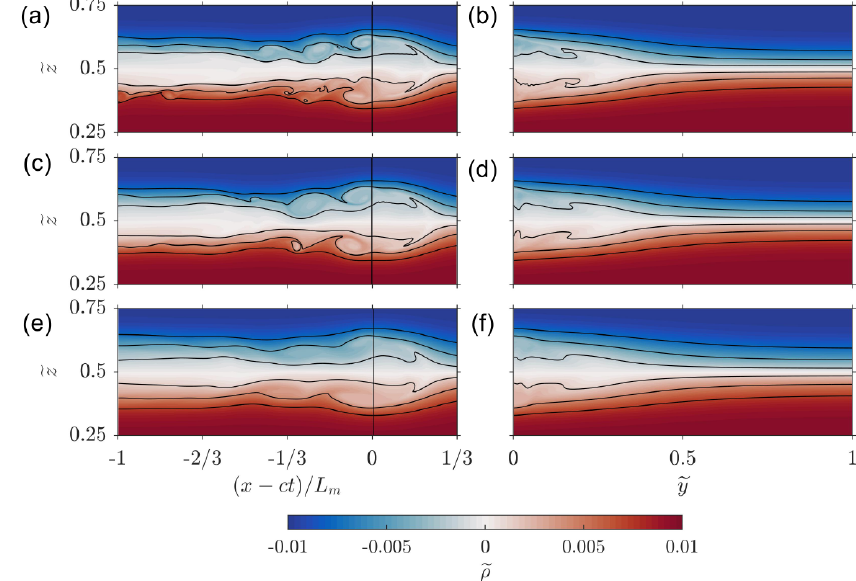
Figure 14. Density anomaly, e ρ , at e t = 5 . 2 (t = 50s ) with cross sections at e y = 0 (first column) and at the location of maximum amplitude (second column) for Sc = (a, b) 10, (c, d) 4, and (e, f) 1. Black contours are the same as in Fig. 9. The vertical black line denotes the location of the cross section shown in the right column. All cases have f/f 0 =